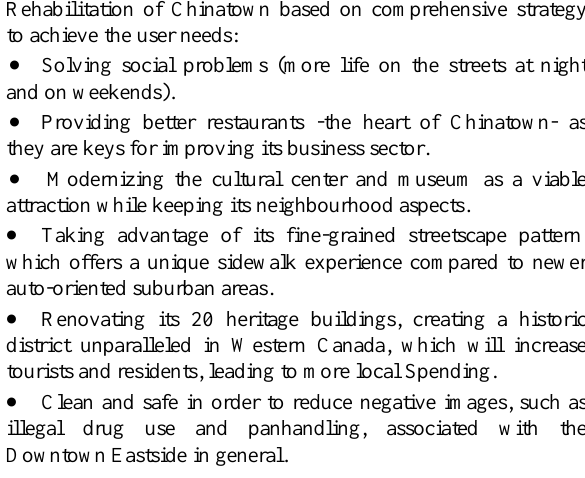
Figure 5. Victory Square.